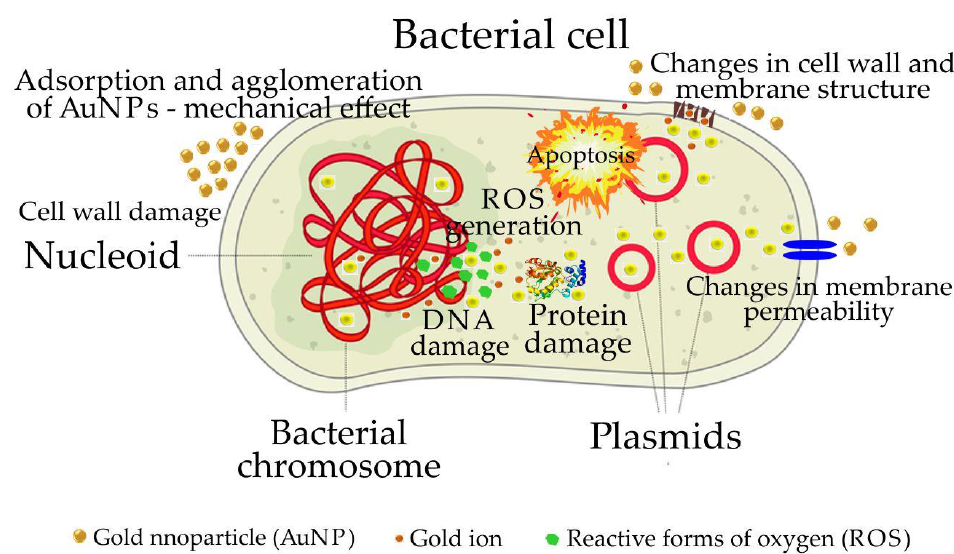
Figure 3. Mechanism of antibacterial action of AuNPs biosynthesized from plants and unreduced gold ions.